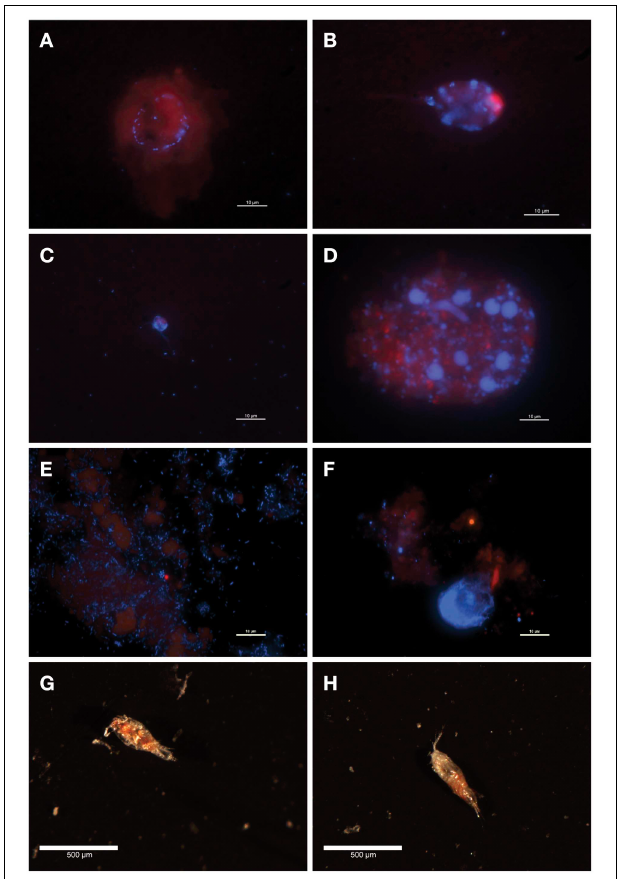
FIGURE 1 | Fluorescence (A–F) and optical (G,H) microscopy images of sediment trap POM. (A) 150m, poisoned trap; A circle of bacteria associated with a chlorophyll-containing particle (B) 200m, poisoned trap; Unattached, ovoid pigmented cell in class Dinophyceae (C) 300m, poisoned trap; A dually flagellated cell in class Chrysophyceae loosely surrounded by bacteria (D) 500m, poisoned trap; A chlorophyll-containing particle covered with non-pigmented cells of varying sizes including flagellates in class Chrysophyceae and large bacteria (E) 150m, live trap; Abundant bacteria, some associated with diffuse chlorophyll-containing particles (F) 150m, poisoned trap; Sparsely distributed bacteria associated with a chlorophyll-containing particle (G) 150m, live trap; Partially degraded copepod (H) 150m, poisoned trap; Slightly degraded copepod.